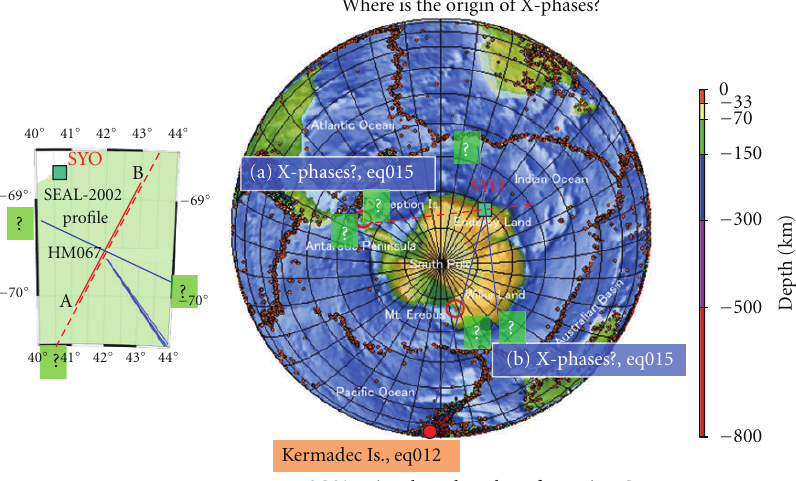
Figure 17: Plausible candidates of the location for X-phases (event#; eq015), overprinting on the background seismicity (by USGS/NEIC) around Antarctic Plate. Hypocenter of the Kermadec Is. earthquake (event#; eq012) is also presented for comparison.